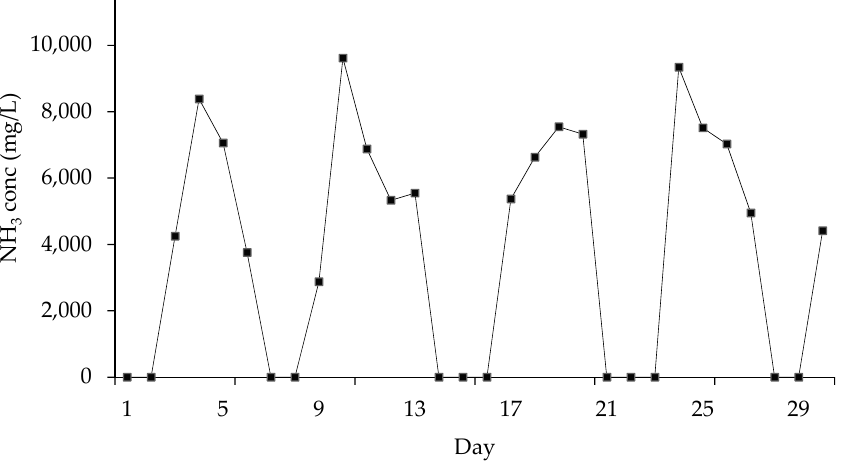
Figure 1. Variation in NH 3 levels in RCWW over the course of one month (April 2018).